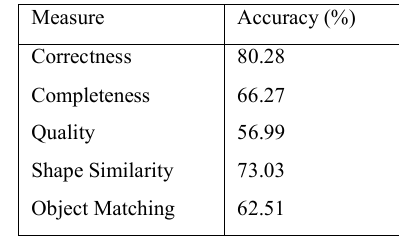
Table 2. Accuracy assessment result of the extracted landslides by different measures Table 1. Comparisons between OBIA extracted and reference landslides Similarly, 40 matching landslides were selected randomly for shape similarity and object matching assessment.